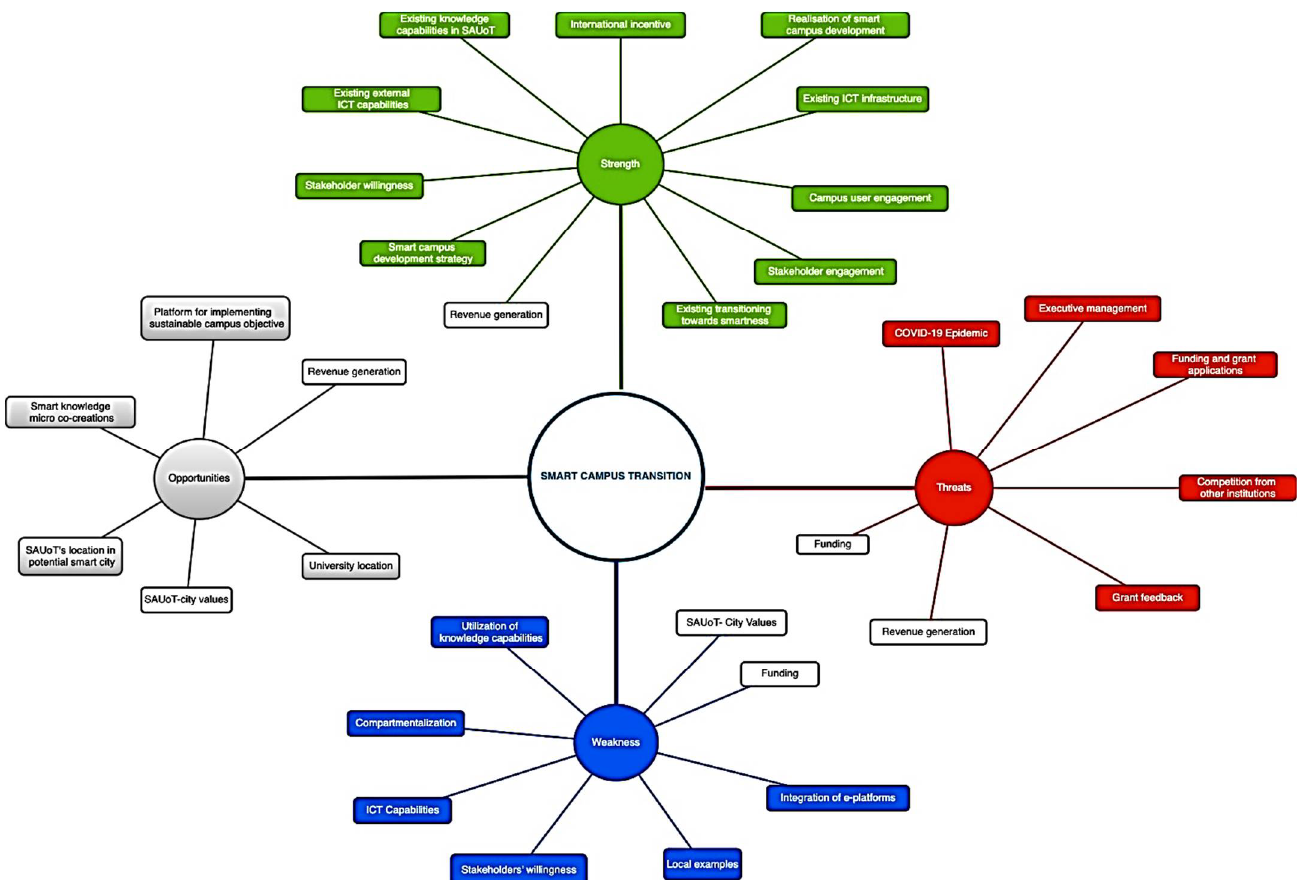
Figure 9. A framework for managing SWOT factors influencing Smart Campus transitions.